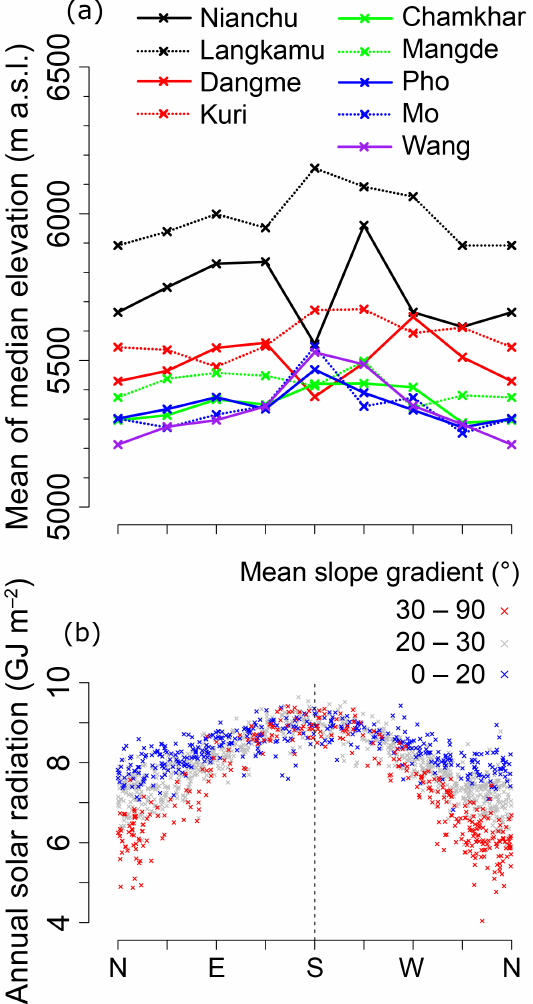
Figure 14. (a) Median elevations in 9 of 11 river basins (Fig. 1) are plotted along eight aspects. (b) Estimated mean values of an- nual solar radiation for respective ALOS-derived glacier outlines, for which glaciers are grouped into three classes based on their mean slope gradients.